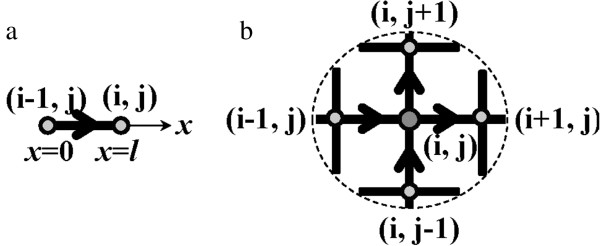
Illustrations of (a) mesh segmentSi,jLand (b) mesh node ( i , j).